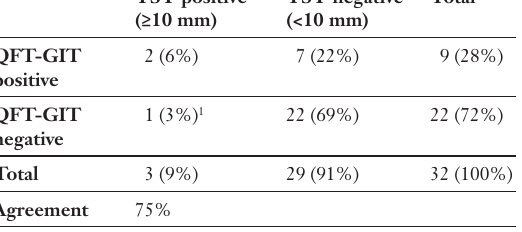
Same as 3A with lower TST cut-off (≥5